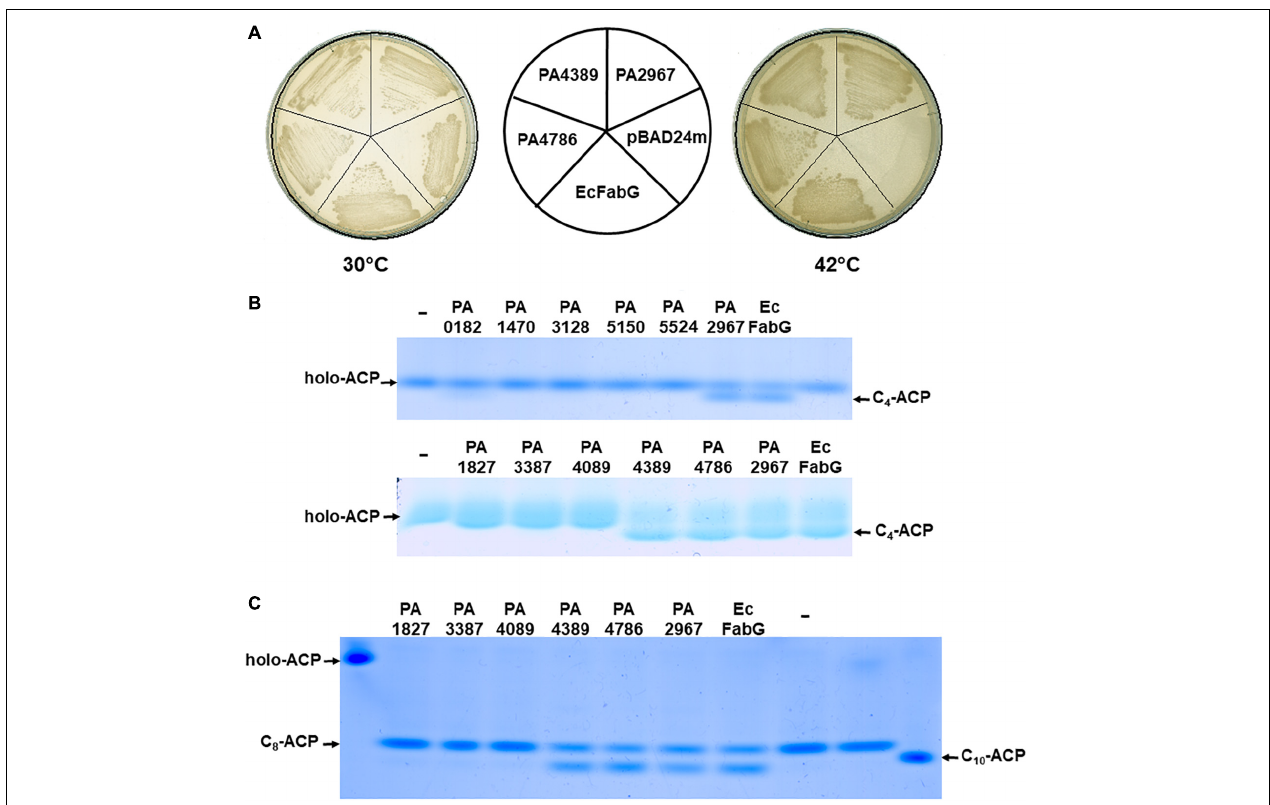
FIGURE 1 | Examination of OAR activities of P. aeruginosa OAR homolog proteins in vivo or in vitro . (A) Complementation of the E. coli fabG (Ts) strain CL104 by expression of P. aeruginosa OAR homolog proteins. The E. coli FabG (EcFabG), PA2967, PA4389 and PA4786 proteins were expressed from pBAD24M-derived plasmids listed in Supplementary Table S1 . (B) P. aeruginosa OAR homolog proteins function in the first cycle of fatty acid biosynthesis. (C) OAR homolog proteins function in the elongation reactions of fatty acid biosynthesis. C 4 -ACP, butyryl-ACP; C 8 -ACP, octanoyl-ACP; C 10 -ACP, decanoyl-ACP. The pET28b-derived plasmids, which carried 12 OAR encoded genes, were expressed in E. coli BL21 (DE3) and OAR proteins were purified by nickel chelate chromatography. The fatty acid biosynthetic reactions were reconstructed in vitro as described in Section “Materials and